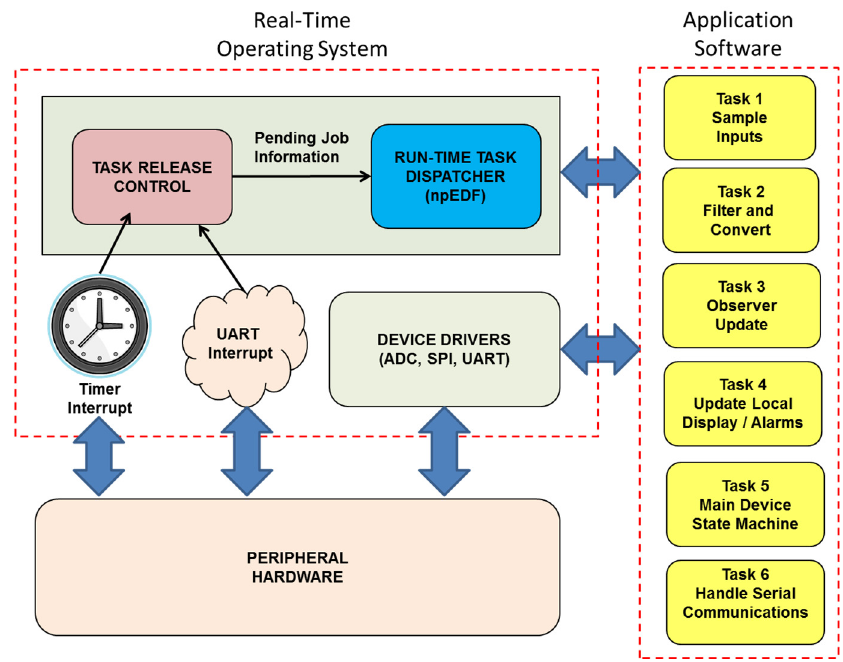
Figure 5. Main software elements employed in the system.